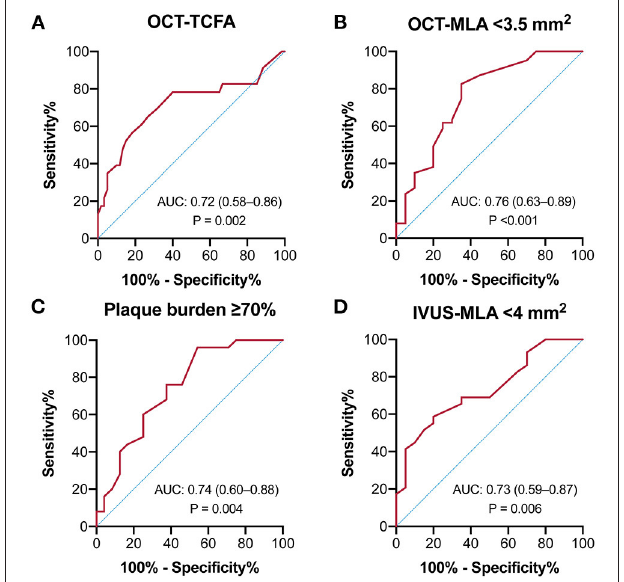
FIGURE 5 | Receiver-operating characteristics curves of QFR to predict intravascular imaging-derived characteristics. The predictive ability of QFR was modest for (A) OCT-TCFA, (B) OCT-MLA < 3.5 mm 2 , (C) Plaque burden ≥ 70%, and (D) IVUS-MLA < 4 mm 2